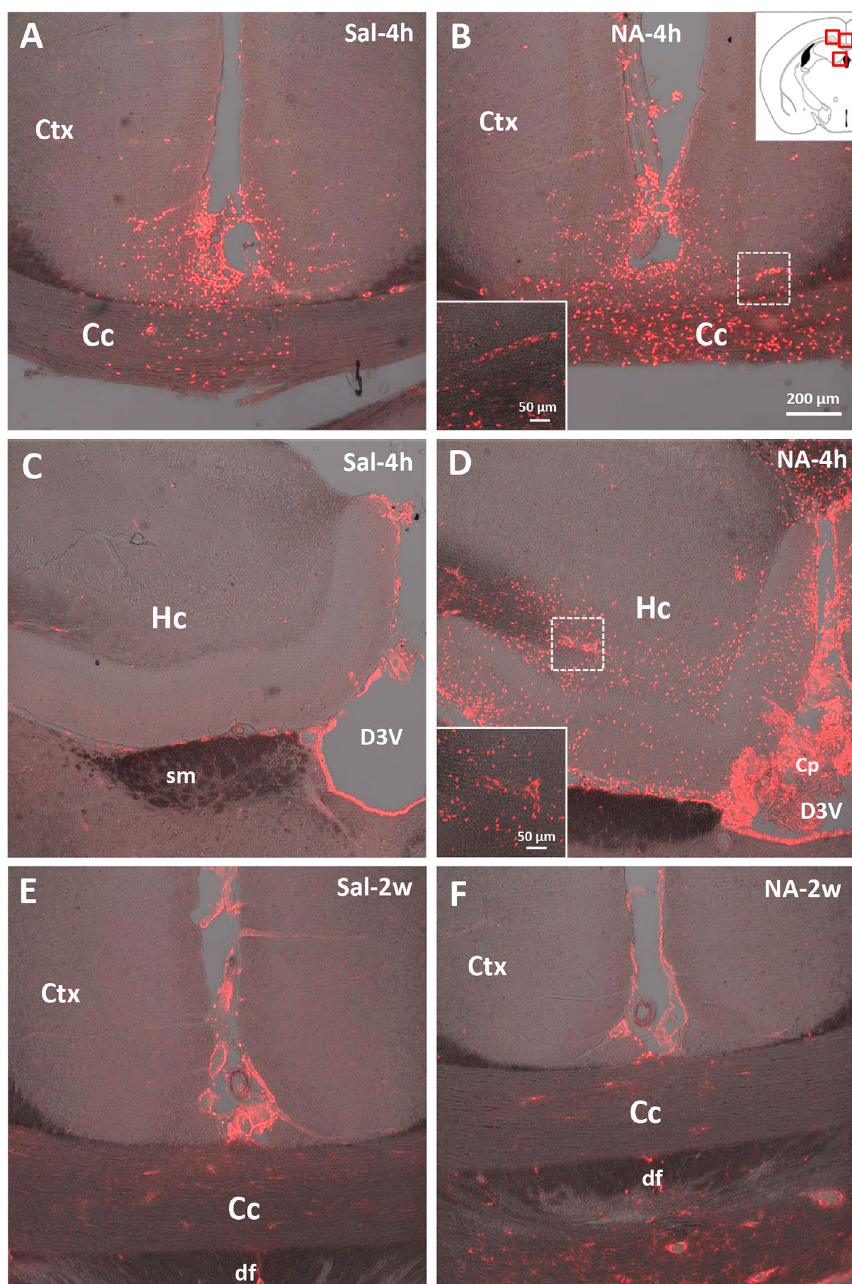
Figure 6. Infiltration of peripheral cells revealed by Gal3 immunostaining. Both animal groups, ICV-injected either with saline (Sal) or with neuraminidase (NA), were sacrificed 4 h (4 h) or 2 weeks (2w) after the ICV. Their brains were removed and processed for Gal3 immunostaining. Rats sacrificed 4 h post-injection ( A – D ) belong to other study, and were used here as a positive control for cell infiltration. The sections immunostained correspond to levels close to the ICV-injection site (see scheme at the top right, where the photographed areas are squared in red). Gal3-positive cells (stained in red) appear in rats sacrificed 4 h after the injection ( A – D ), and are noticeably more abundant in those ICV-injected with NA ( B , D ), revealing infiltration of peripheral cells shortly after the injection. Infiltrated cells are mainly located in the cerebral cortex (Ctx), the corpus callosum (Cc) as well as in the hippocampus (Hc) and the choroid plexus (Cp) located in the dorsal third ventricle (D3V), all close to the injection site. No infiltrating cells are seen after 2 weeks of the ICV injection neither with saline ( E ) nor with NA ( F ). Images in ( A – F ) are a z-stack projection of several confocal planes. Insets in ( B ) and ( D ) are higher magnifications of the regions squared with a broken line in each respective image, and correspond to a single confocal plane. sm stria medullaris thalamus, df dorsal